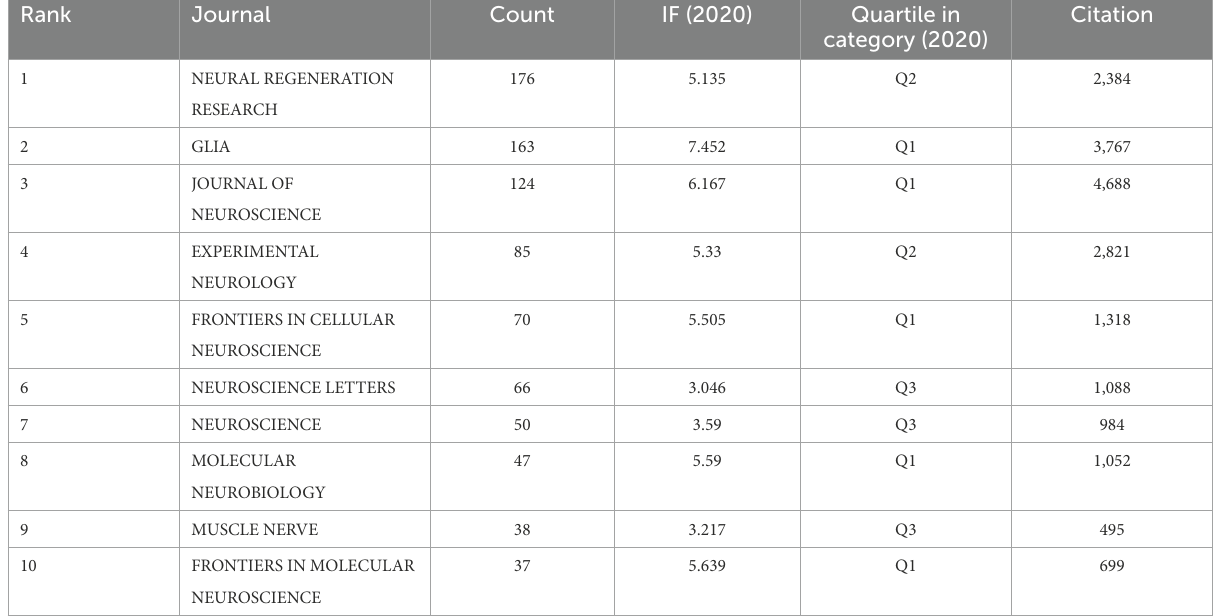
TABLE 2 Top 10 most productive